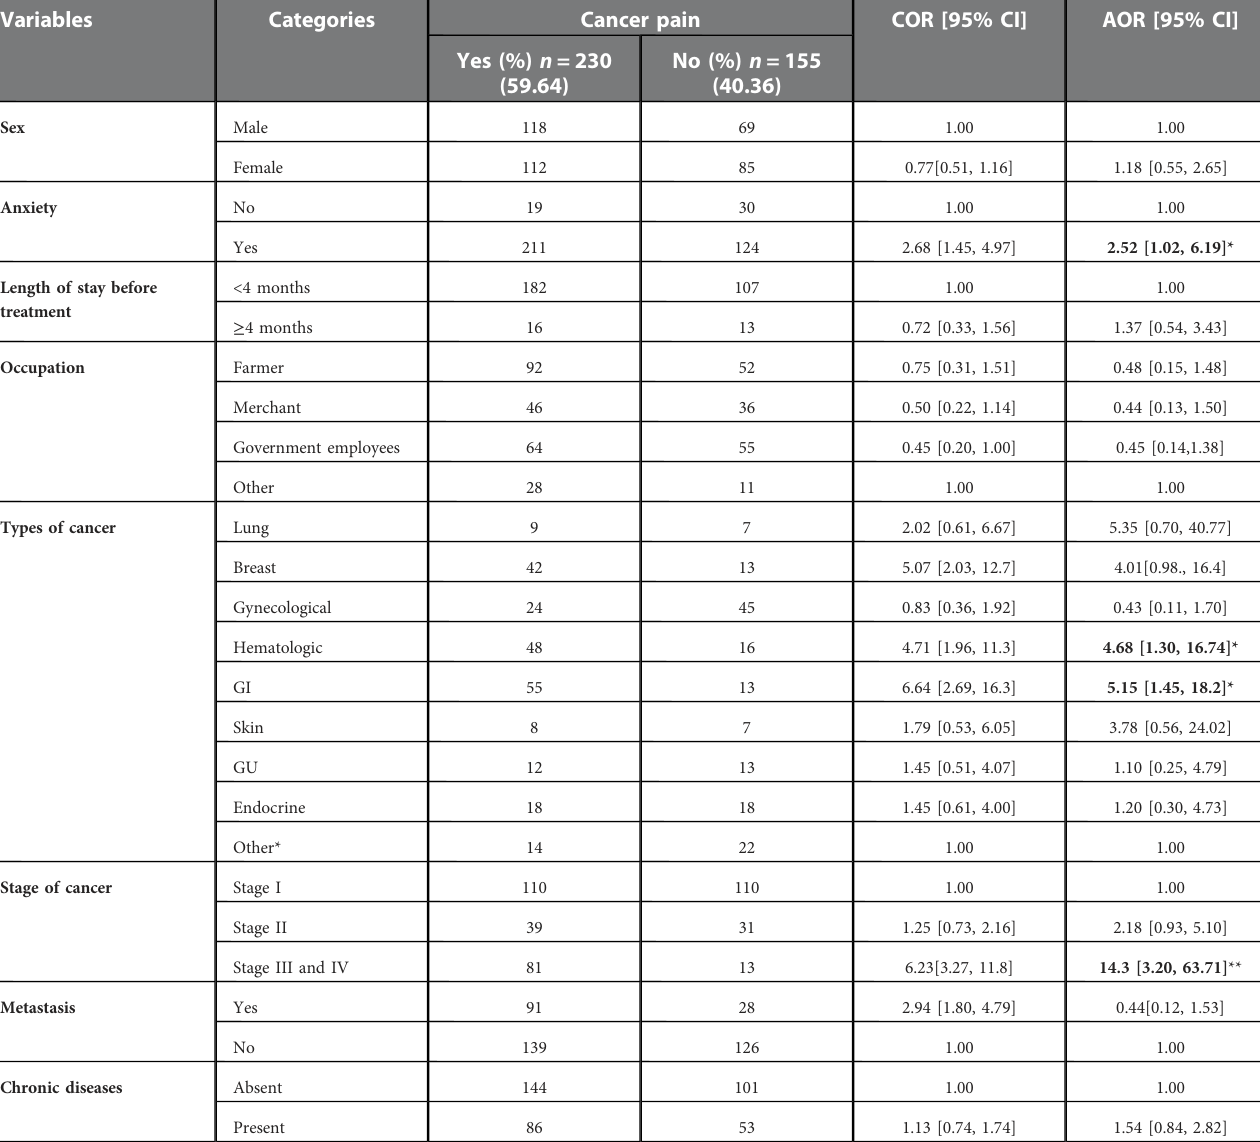
TABLE 4 Bivariable and multivariable analyses of factors associated with cancer pain among patients in the UoGCSH, Northwest Ethiopia 2021.